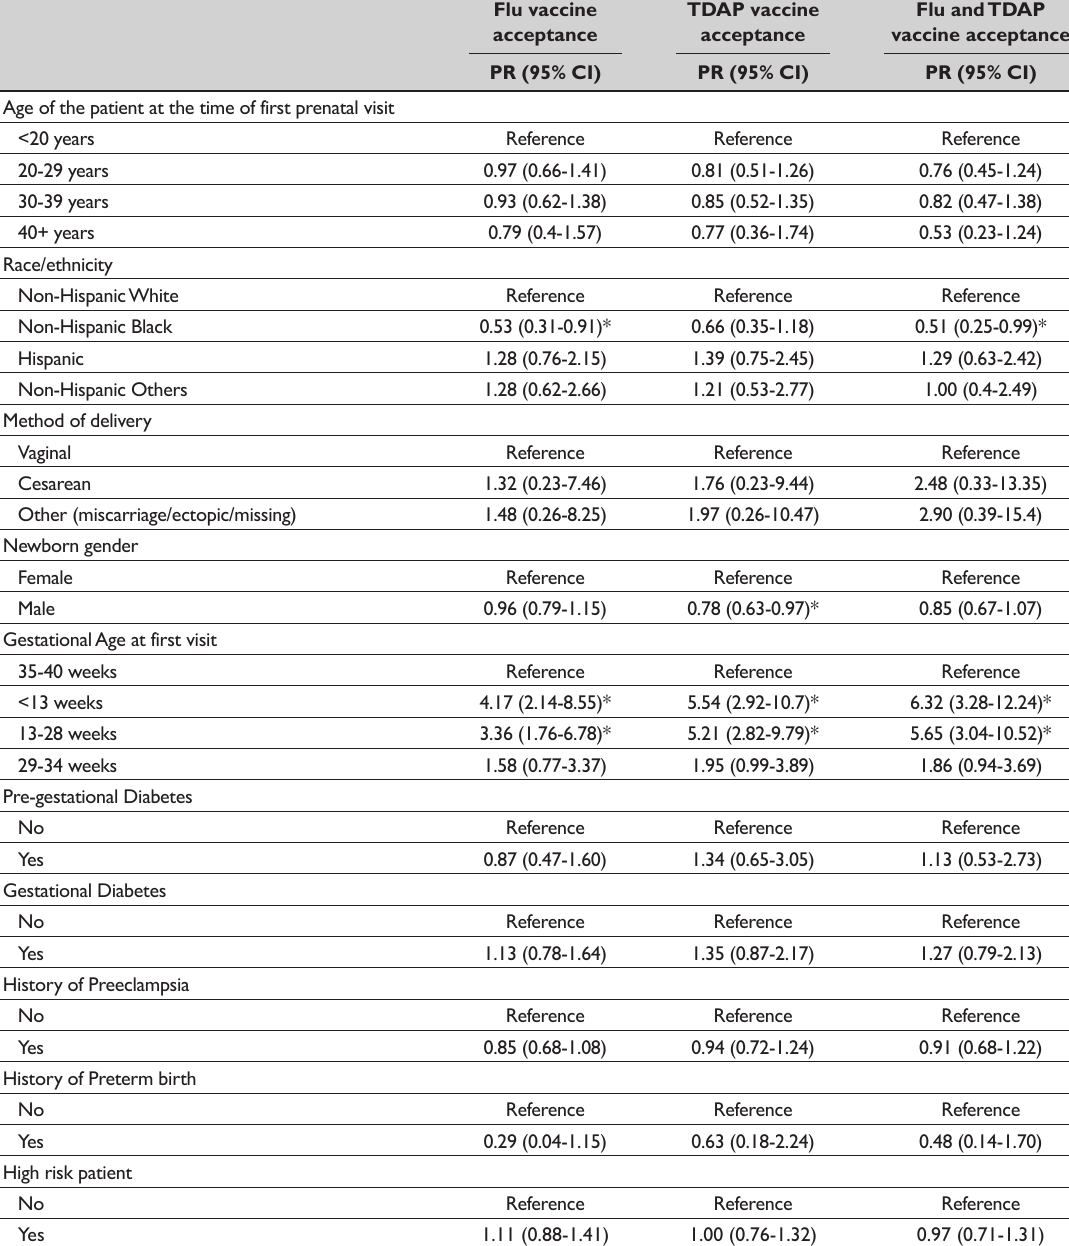
Table 3: Factors associated with Flu, TDAP and both Flu+TDAP vaccine acceptance during COVID-19 period (i.e.